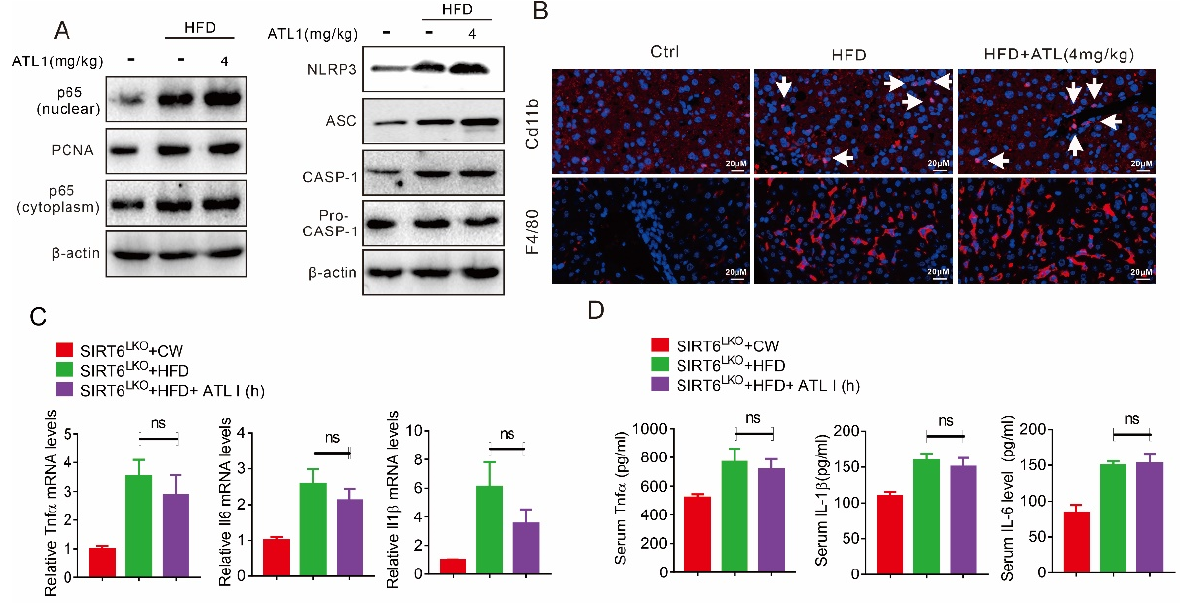
Figure 7. Hepatic SIRT6 deletion diminished the protective effects of ATL I treatment on the NLRP3 inflammasome and inflammatory response in HFD-induced mice. ( A ) Western blot indicated that ATL I treatment failed to decrease the HFD-induced p65 levels in nuclear and NLRP3 inflammasome related proteins in the livers of hepatic SIRT6 knockout mice. ( B ) Immunofluorescence data indicated that an ATL I-induced decrease in Cd11b and F4/80 positive cells in HFD-induced obese mice was abolished due to hepatic SIRT6 knockout. ( C ) ATL I treatment failed to reverse the mRNA levels of inflammatory genes in hepatic SIRT6 knockout mice fed an HFD. ( D ) ELISA data showed no change in serum inflammatory cytokine levels in hepatic SIRT6 knockout mice fed an HFD after ATL I treatment. Results are shown as mean ± SEM (n ≥ 4).